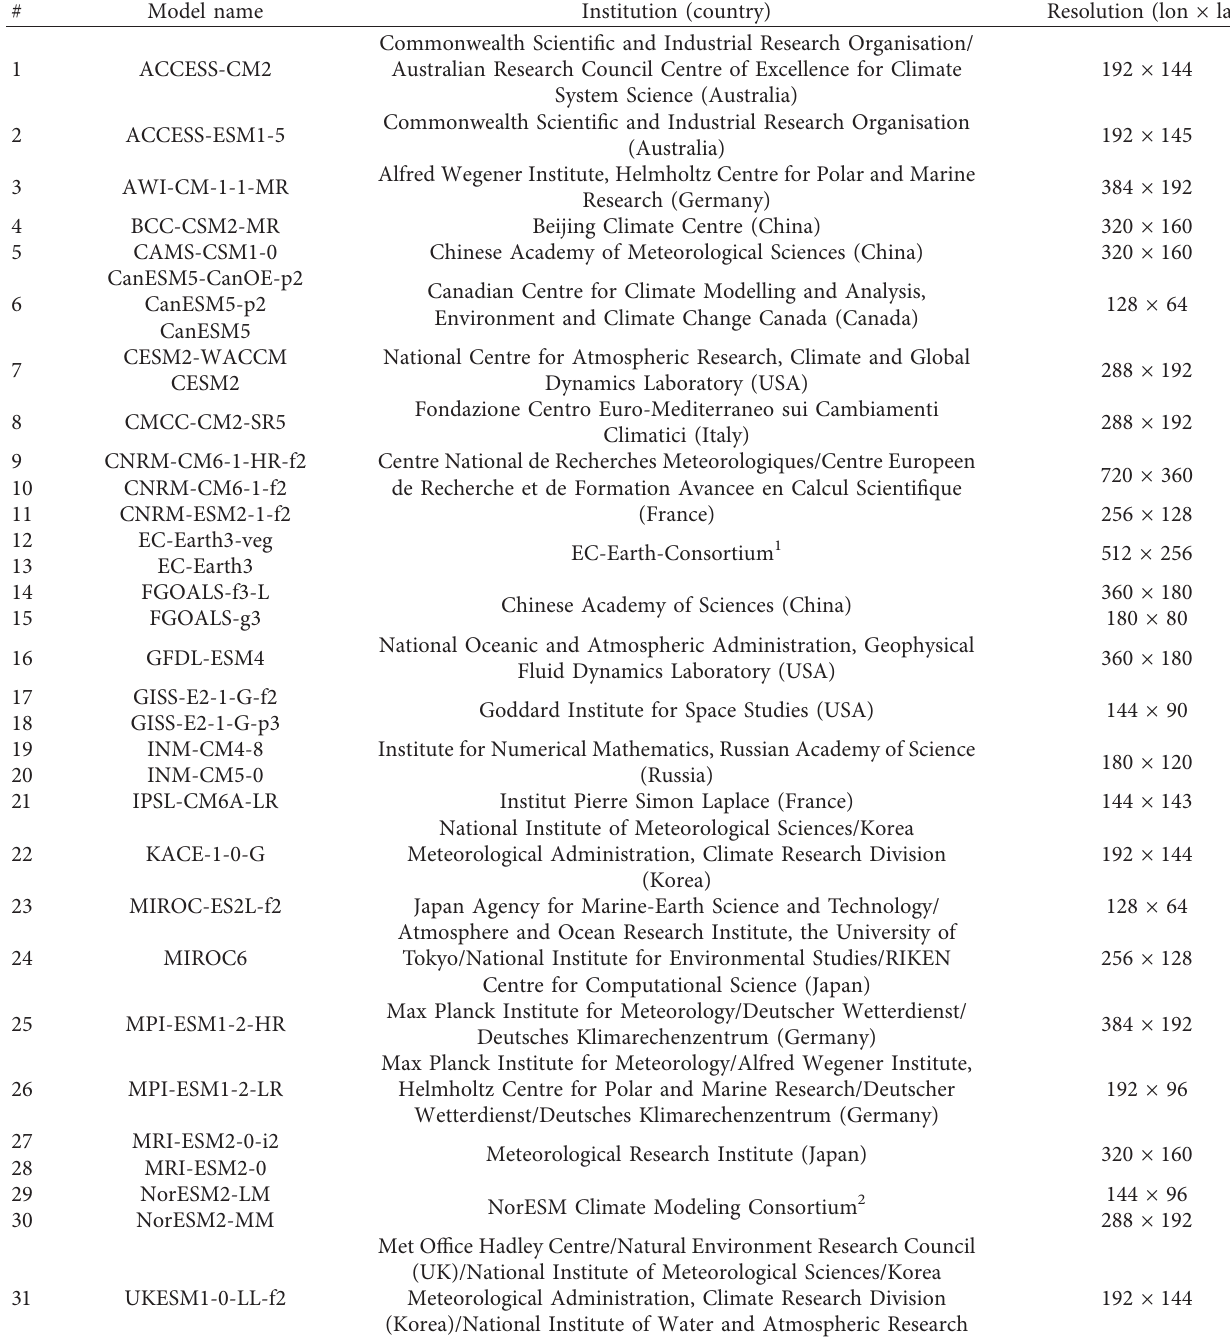
Table 3: List of CMIP6 models used in this